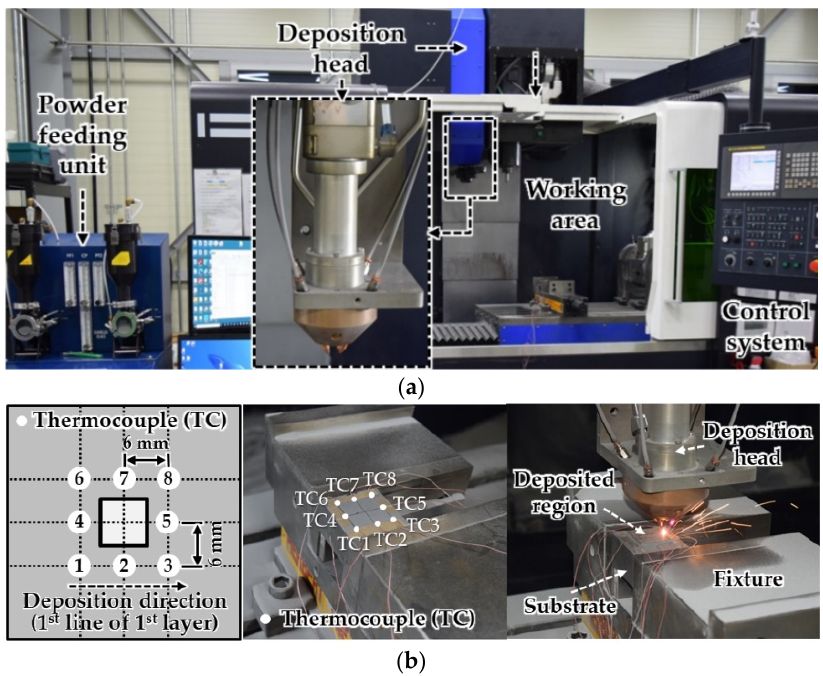
Figure 5. Experimental methodology: ( a ) hybrid directed energy deposition (DED) system incor- porated a laser engineered net shaping (LENS) process; ( b ) experimental setup. Table 3. Chemical composition of Inconel 718 (wt %) [39].